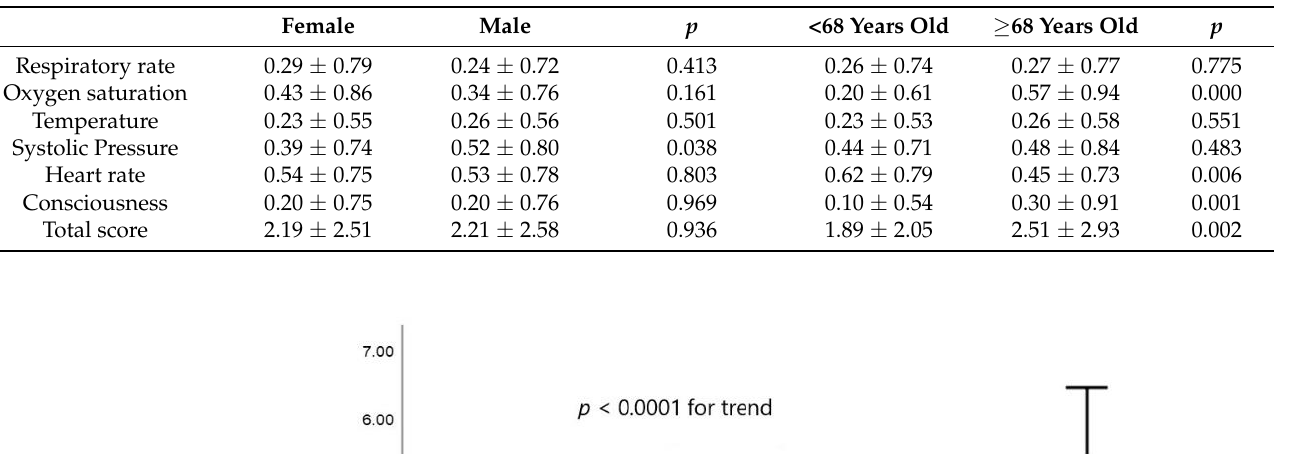
Table 2. NEWS total score and sub-domain score according to population median age or gender.